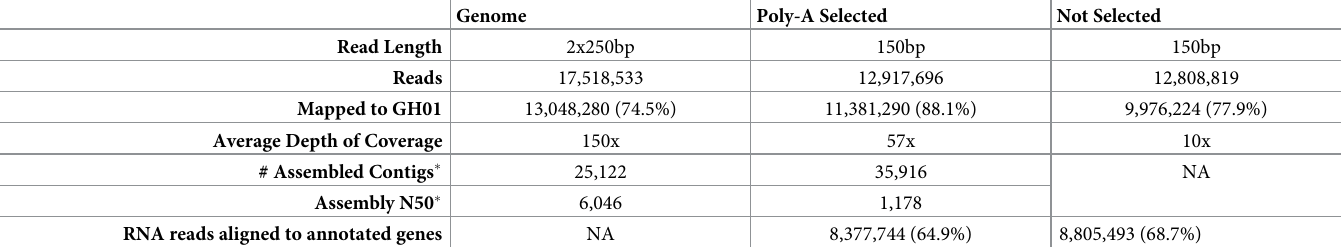
Table 1. Sequencing performance. � For assembly data, the genome and transcriptome had different assembly and post-assembly methodology. For these metrics report, we used all contigs.